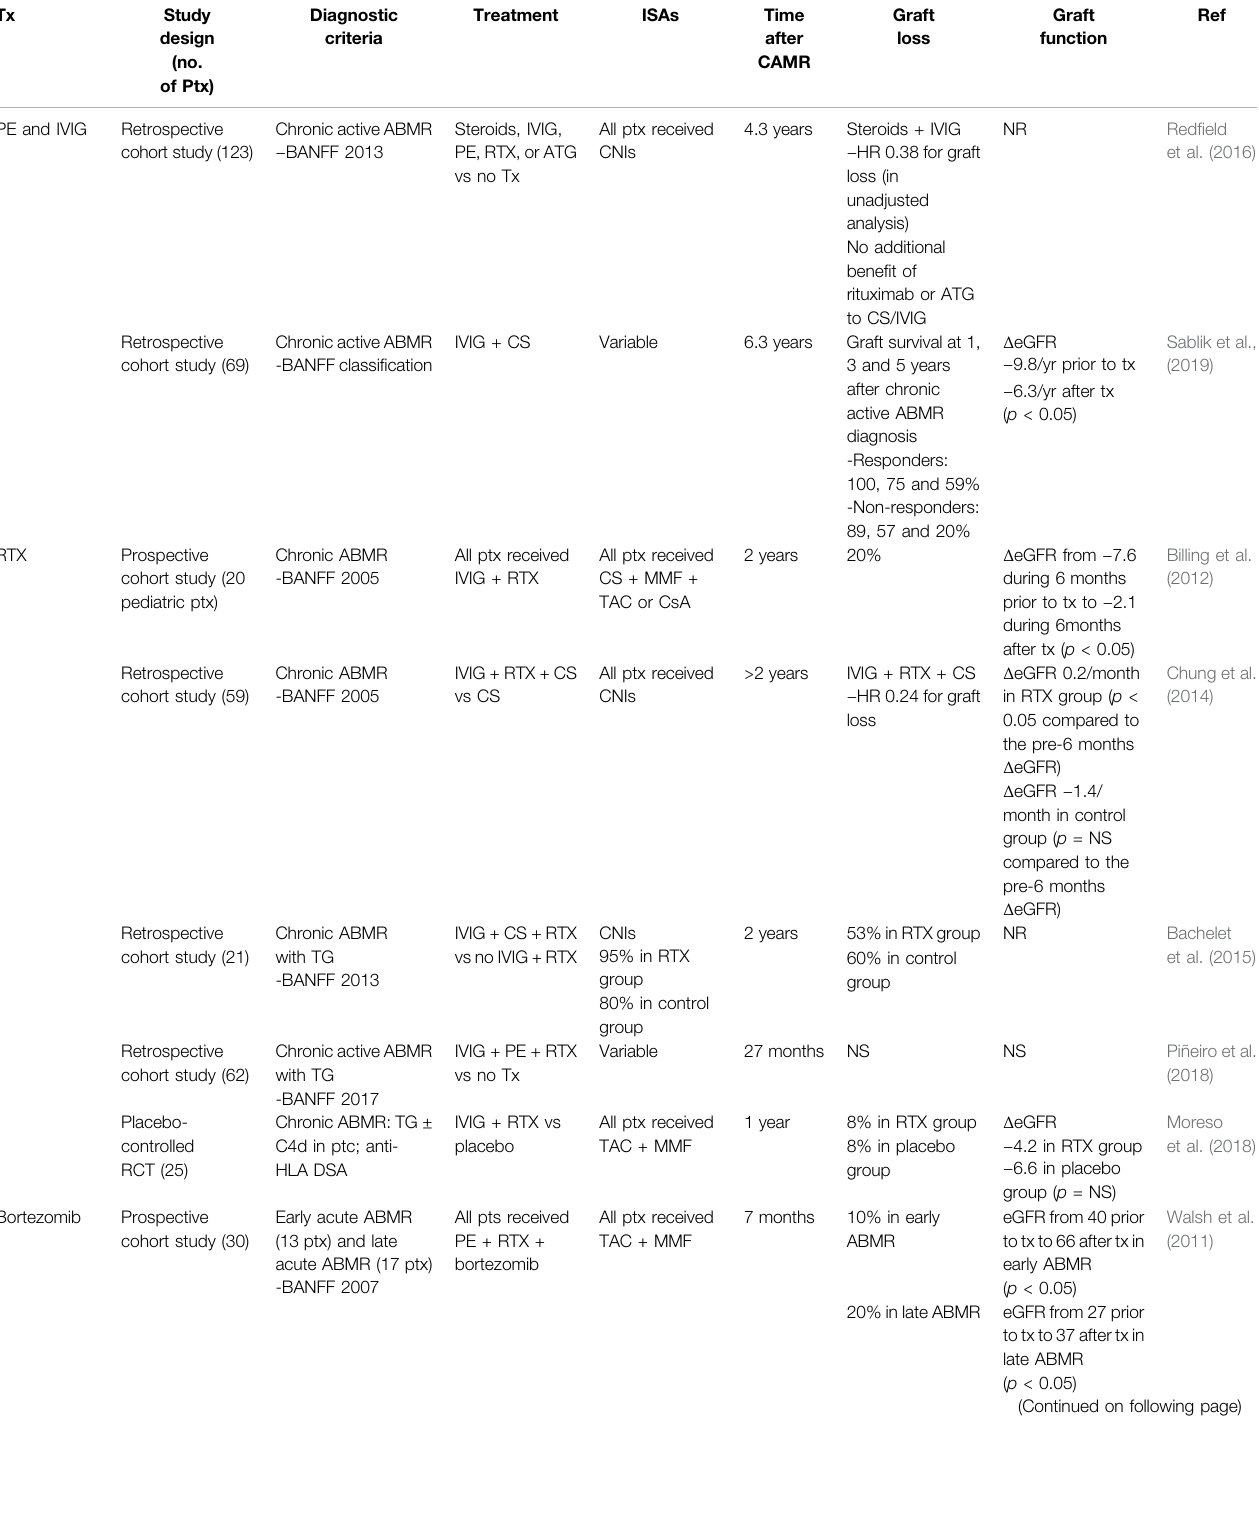
TABLE 1 | Studies for therapy of chronic antibody-mediated